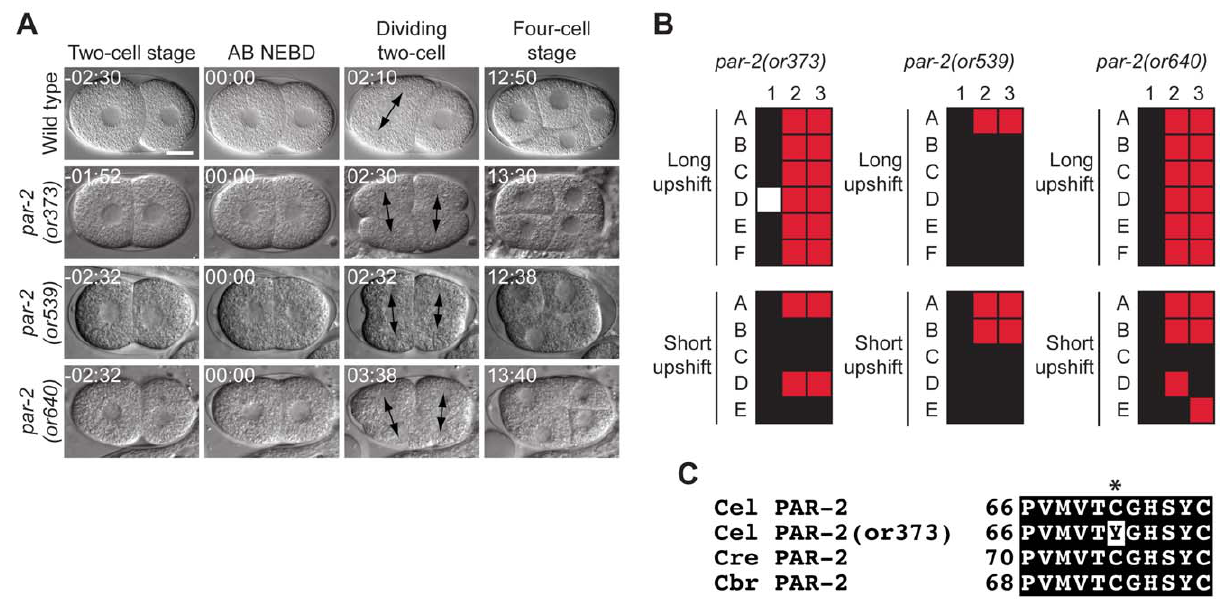
Figure 9. par-2 mutants. A. DIC time-lapse images of wild-type par-2(or373 ts ) , par-2(or539 ts ) , and par-2(or640 ts ) embryos. The blastomeres in the par-2 mutants were of similar size at the two cell stage and initiated mitosis simultaneously, in contrast to the wild type. The par-2(or373 ts ) embryo was obtained from a hermaphrodite shifted to the restrictive temperature for 5 hours prior to imaging. The par-2(or539 ts ) and par- 2(or540 ts ) embryos were obtained from hermaphrodites shifted to the restrictive temperature for 30 minutes prior to imaging. Arrows indicate mitotic spindles at the two cell stage. Times in min:sec are given relative to AB NEBD. Scale bar, 10 m m. B. Defect map for individual embryos observed during time- lapse recordings, embryos are listed on the left and phenotypes are listed on the top: 1; Normal one cell embryo; 2; assymetric two cell embyro, 3; asynchronous two cell divisions. In the long upshifts, hermaphrodites were transferred to the restrictive temperature for 5–8 hours. In the short upshifts, embryos were harvested from hermaphrodites transferred to the restrictive temperature for 30 minutes. C. Amino acid alteration in the par- 2(or373 ts ) mutant. Asterisk indicates the changed residue. Homologous proteins are aligned below the C. elegans protein. doi:10.1371/journal.pone.0016644.g009 . 10 L4 hermaphrodites to individual plates and grew them at the permissive (15 u C) or restrictive (26 u C) temperatures until broods were produced. We then removed the worms and allowed the embryos to develop prior to counting viable and inviable progeny. For testing embryonic lethality in heterozygous mothers, we crossed the mutants to a him-5 strain and tested the F1 progeny as described above. For determining the phenotypes of the TS mutants when shifted to the restrictive temperature from the L1 larval stage, we performed hypochlorite treatments and allowed the embryos to hatch in M9 buffer at 15 u C. We then plated , 100 synchronized L1 larvae onto a plate and grew them at 26 u C until they reached adulthood.